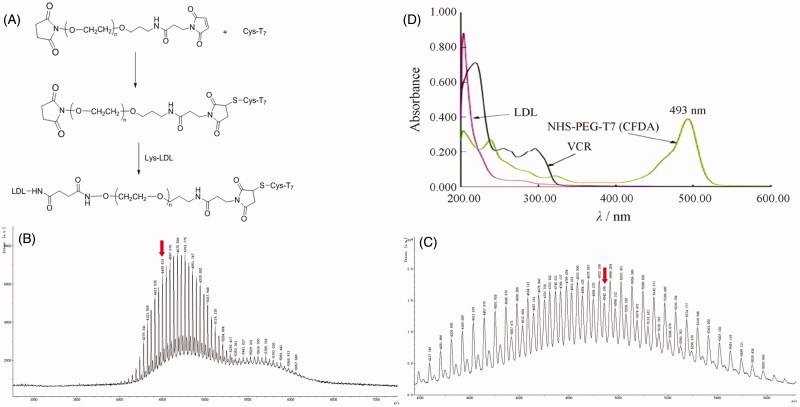
(A) Principle of the preparation of T7-LDL. MALDI-TOF mass spectra of (B) NHS-PEG2000-T7 and (C) NHS-PEG2000-T7(CFDA). Ultraviolet visible spectrum scan of (D) LDL, NHS-PEG2000-T7(CFDA) and free VCR solution. Red arrows represent the theoretical mass-charge ratios of (B) NHS-PEG2000-T7 and (C) NHS-PEG2000-T7(CFDA).